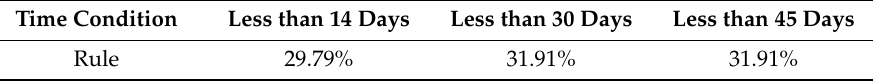
Figure 7. Histogram of the number of occurrences with regard to maintenance categories. ( x - and y -axes are maintenance categories that happened sequentially, and the number of occurrences, respectively). Table 3. The accuracy of the long cycle maintenance time prediction with the